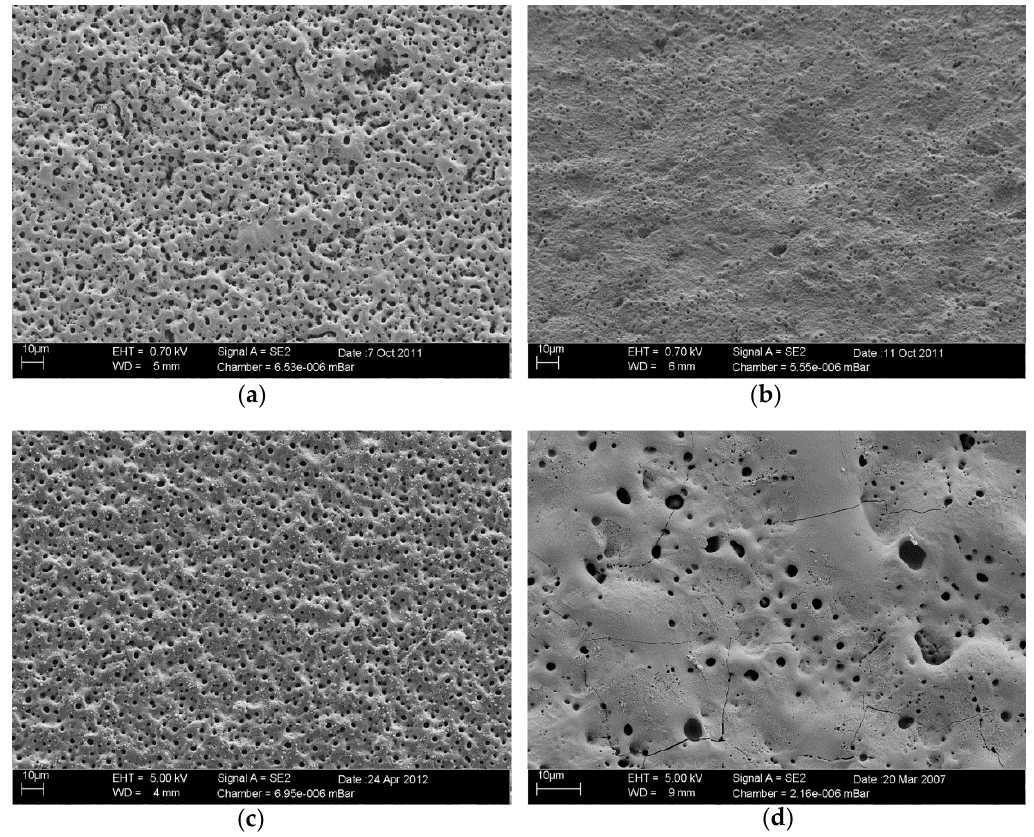
Figure 2. Surface characterization by scanning electron microscopy: ( a ) bioactive macroporous TiOB ® (TiOB ® control); ( b ) TiOB ® functionalized with gentamicin-tannic acid (TiOB ® gta); ( c ) TiOB ® functionalized with silver nanoparticles (TiOB ® SiOx Ag); ( d ) TiOB ® functionalized with ionic zinc (TiOB ® Zn).